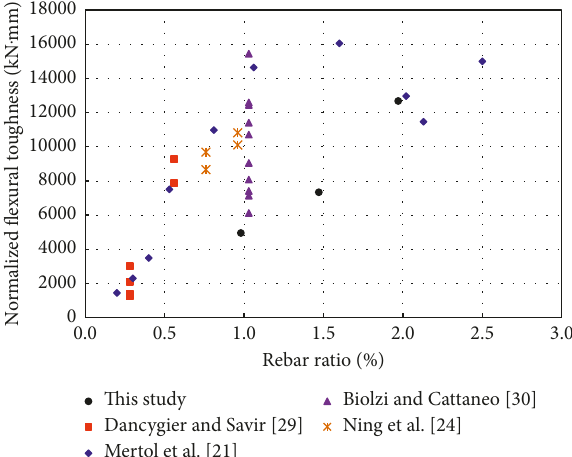
Figure 12: Normalized flexural toughness of the HSC and HSFRC